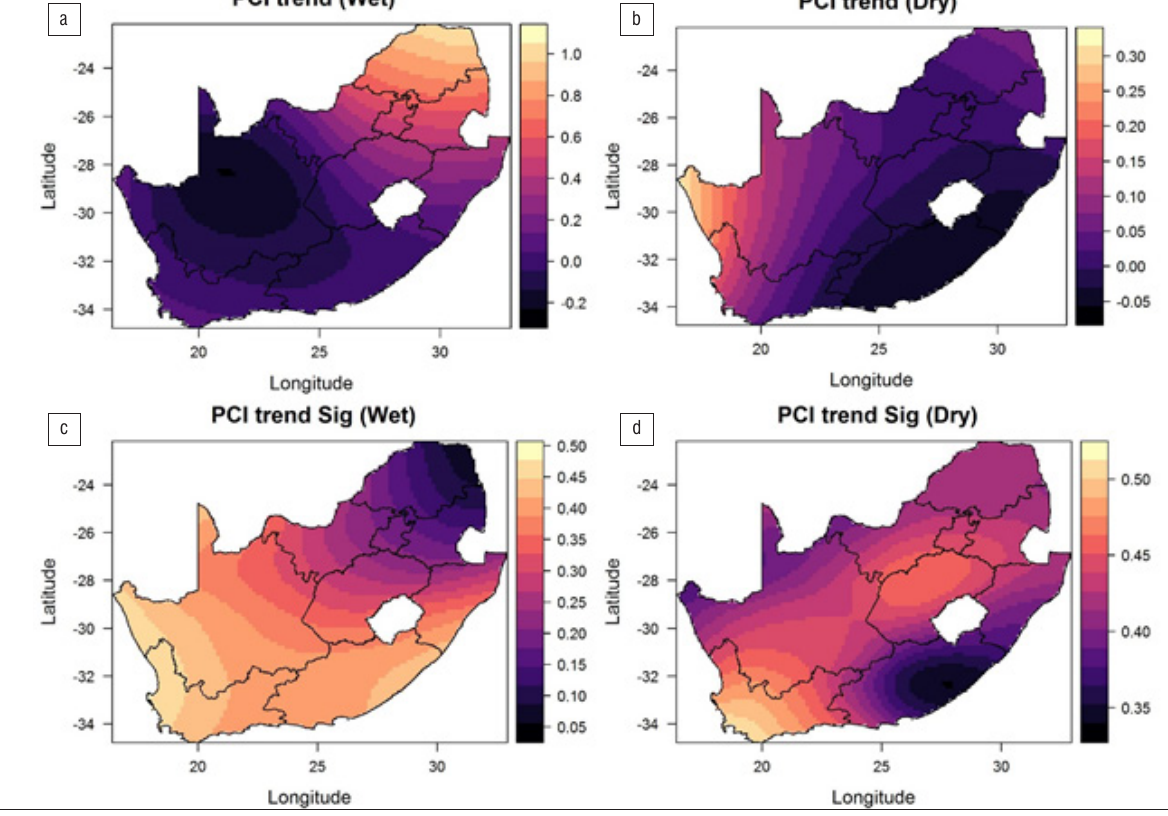
Figure 8 : Supra-seasonal precipitation concentration index (PCI) trends for (a,c) wet and (b,d) dry